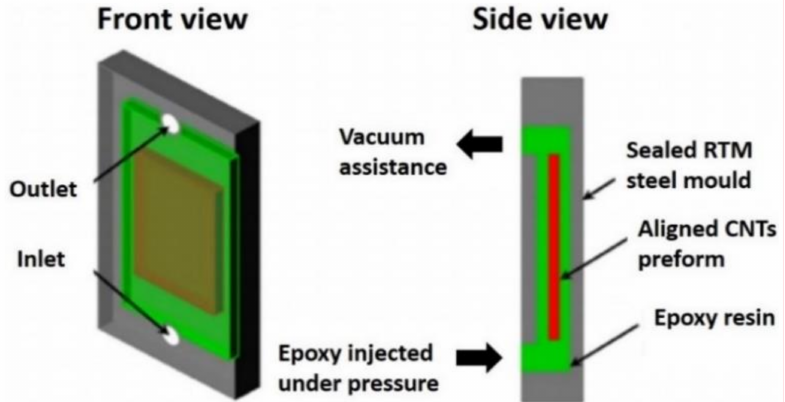
Figure 5. Schematic of the resin transfer molding process for fabricating CNT/epoxy composites. Adapted from